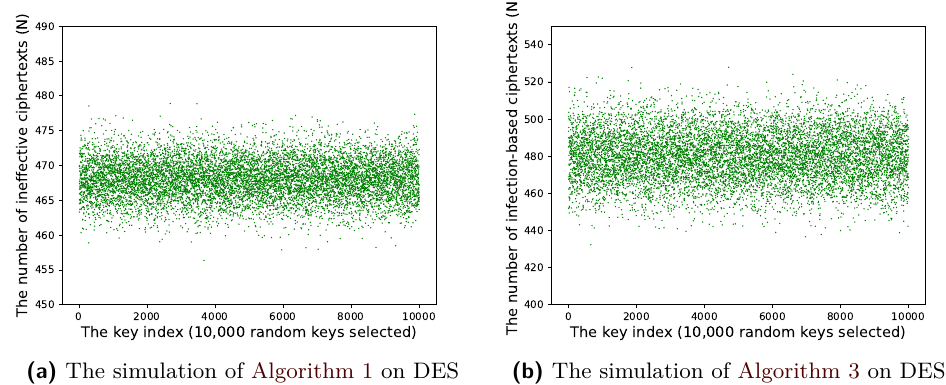
Figure 2: Distribution of the required number of ciphertexts to determine a word of sk n , when the fault location and value are